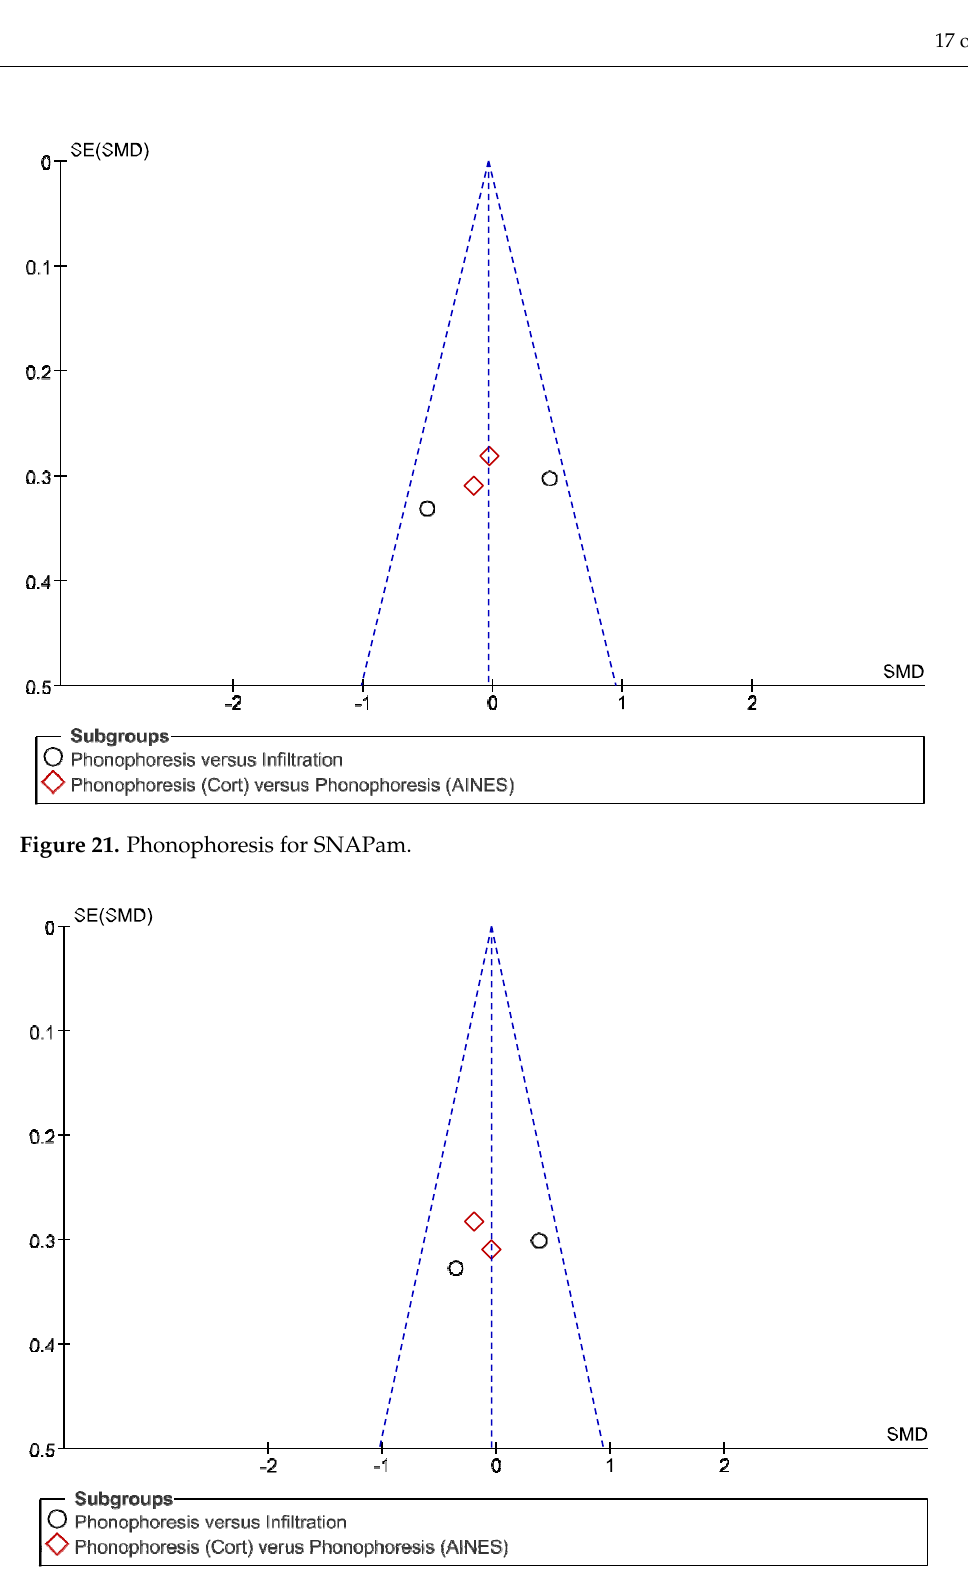
Figure 22. Phonophoresis for CNVM.